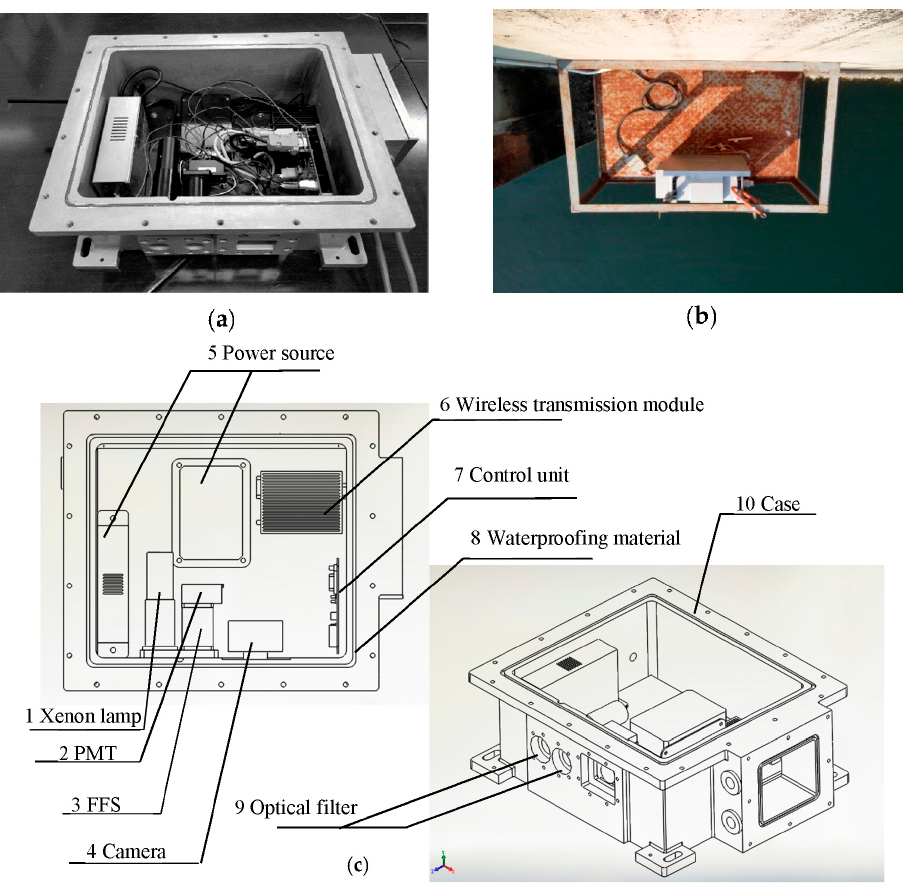
Figure 1. Schematic diagram of the coastal-mounted sensor for monitoring oil spills: ( a ) the internal structure; ( b ) installation drawing; and ( c ) structural sketch of the coastal-mounted sensor. Table 1. The main parameters of the coastal-mounted